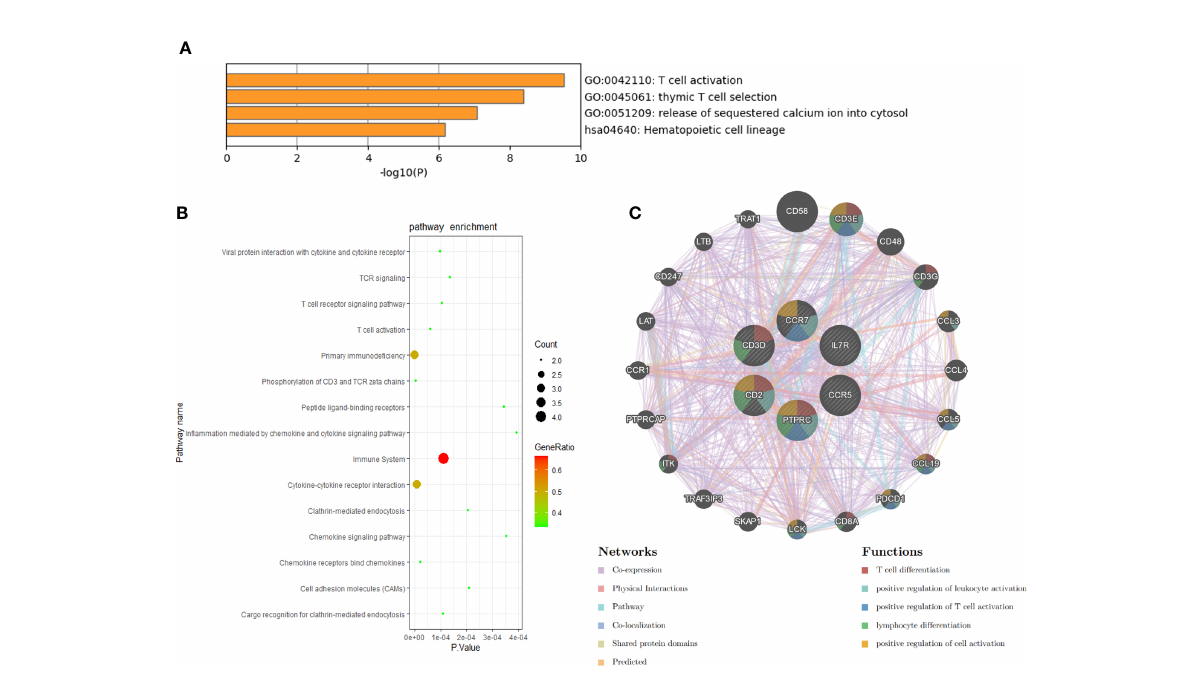
FIGURE 6 Biological process, pathway, and co-expression analysis of the hub genes. (A) The functional annotation analysis of hub genes via Metascape. (B) The further pathway enrichment analysis of hub genes by KOBAS 3.0. P-value < 0.05 was considered signi fi cant. (C) The network of hub genes and their co-expression genes were constructed and analyzed by GeneMANIA.